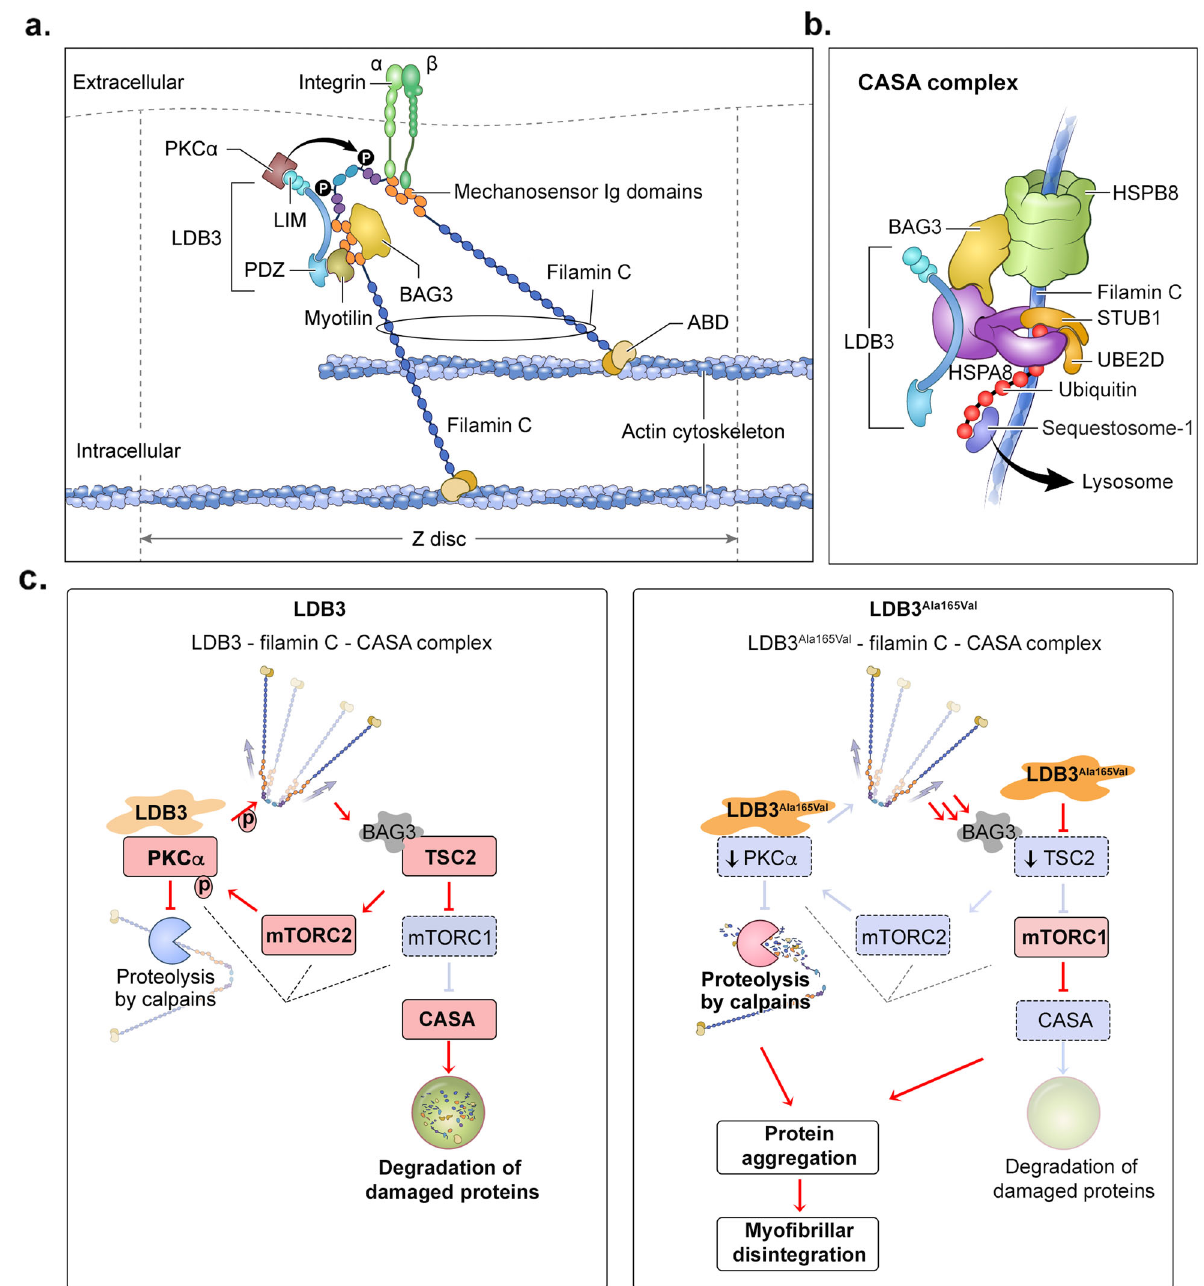
mutations in fi lamin C and CASA components BAG3,